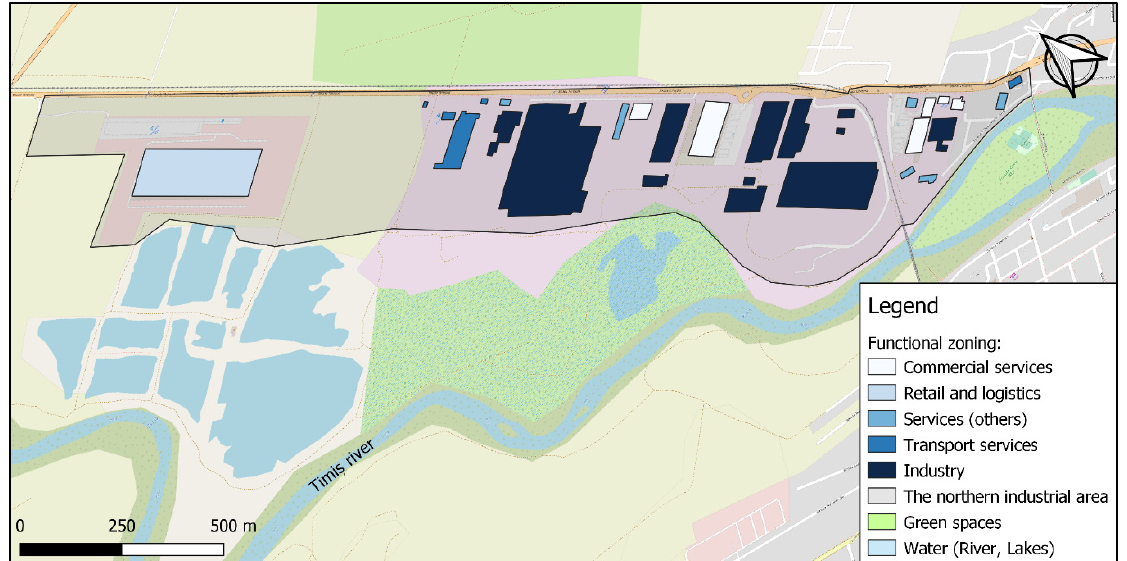
Figure 5 . Mapping functional zones based on their profile in the northern industrial area of Lugoj Municipality, 2022 .